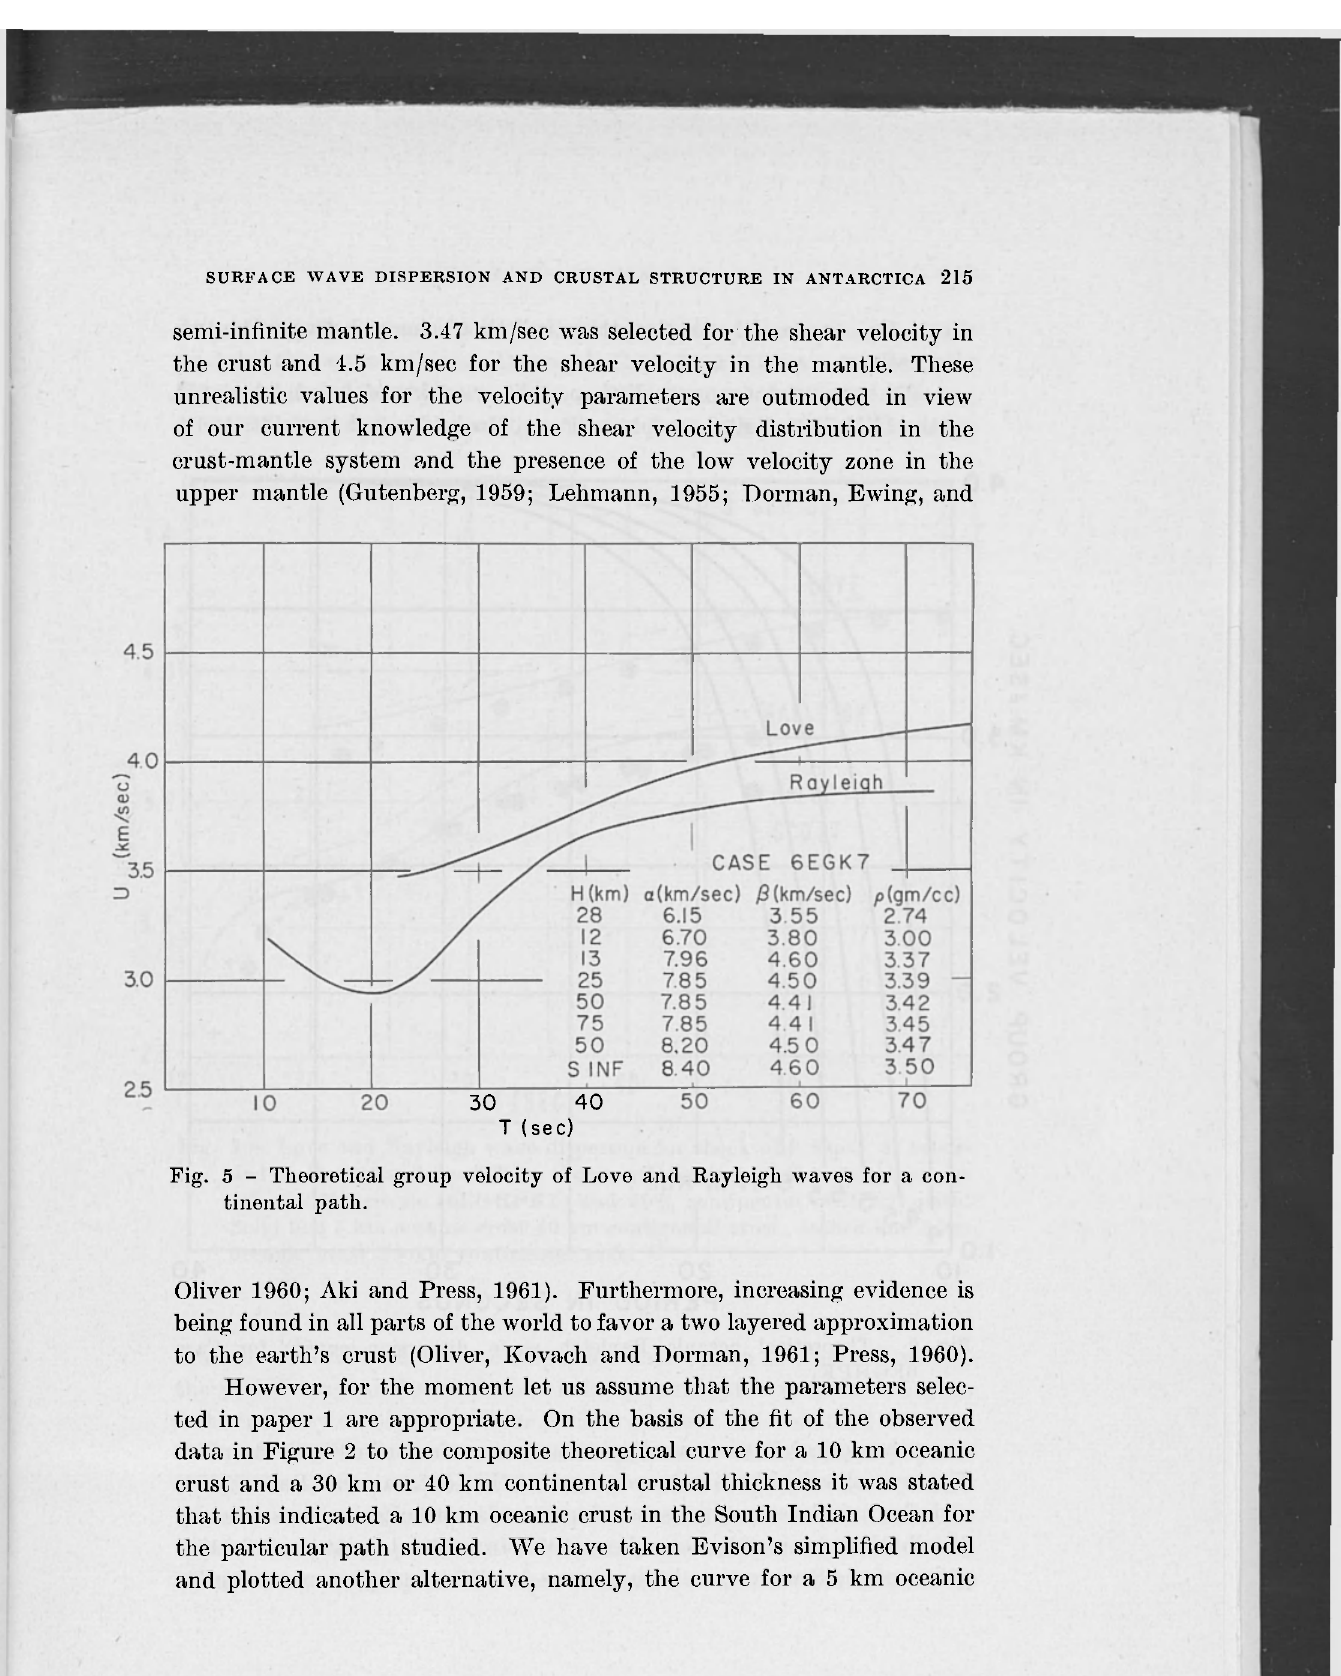
Fig. 5 - Theoretical group velocity of Love and Rayleigh waves for a con- tinental